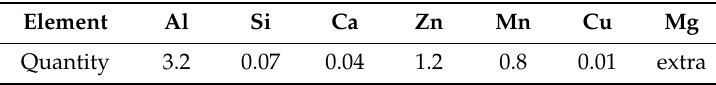
Table 1. The chemical composition of